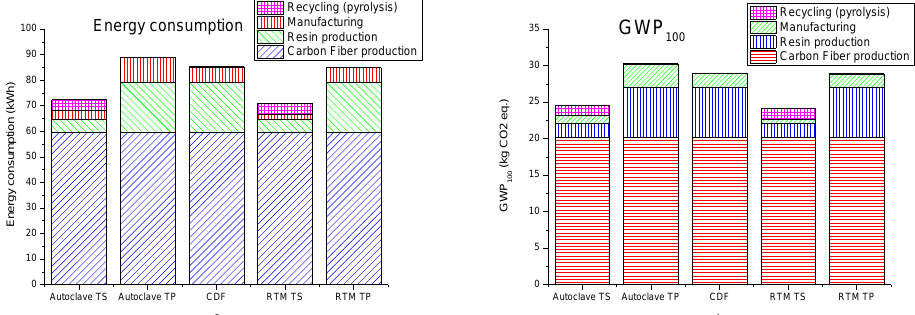
Figure 4. ( a ) Total energy consumption and ( b ) Global Warming Potential-100 for each process scenario when mechanical recycling is considered.